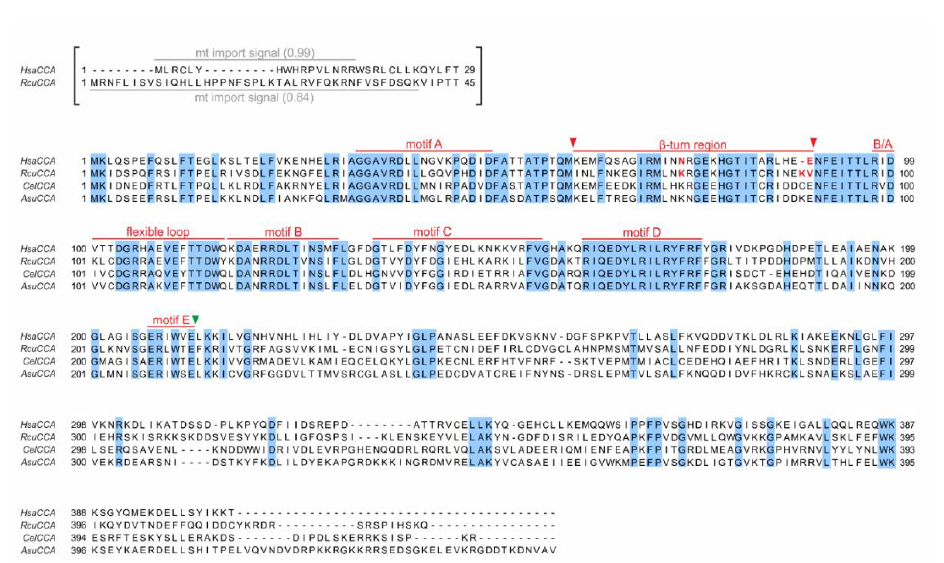
Figure 1. Sequence alignment of CCA-adding enzymes from Homo sapiens, Romanomermis culicivorax, Caenorhabditis elegans , and Ascaris suum . Light blue positions indicate identical residues. The predicted mitochondrial import signals for H. sapiens CCA ( Hsa CCA) and the R. culicivorax CCA-adding enzyme ( Rcu CCA) (grey bars, import probability is given in brackets) are shown in brackets and were excluded from the cloned open reading frames. Catalytically important elements are labeled in red. Fusion position of reciprocal chimeras A and B are indicated by a green arrowhead. Fusion positions of chimera E ( β -turn element) are indicated by red arrowheads (K / I61–E / V90). Mutations K74N and K89Δ/V90E introduced in Rcu CCA and N74K and K89ins/E90V in Hsa CCA are indicated in red.